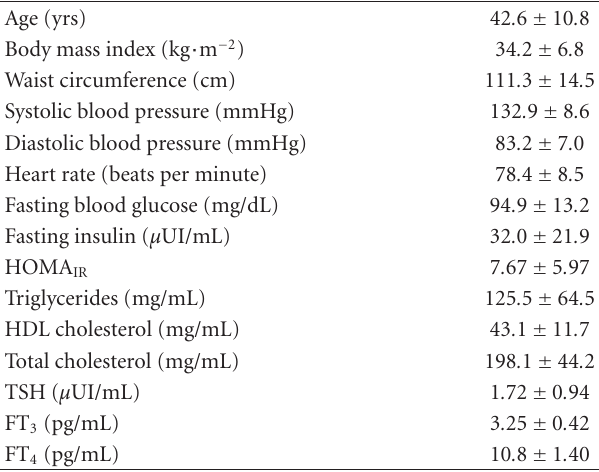
Table 1: General and anthropometric parameters, ABPM data, and metabolic and hormone variables in subjects under study ( n =